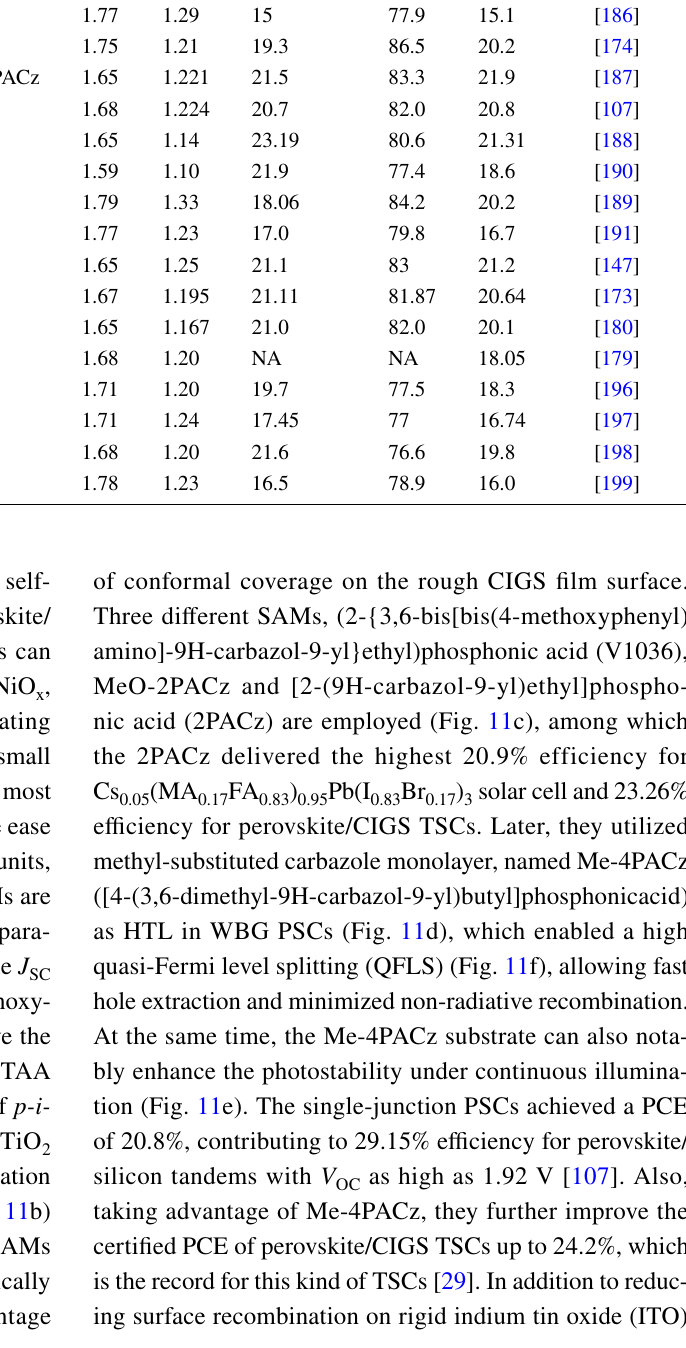
Table 4 Summary of WBG PSCs with different CTLs Perovskite CTL E g MAPbBr 0.8 I 2.2 MAPbBr 0.5 I